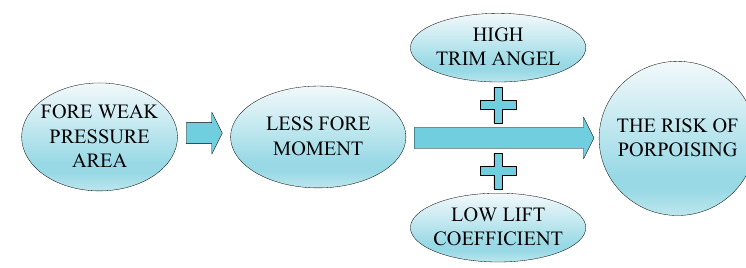
Figure 19. Why porpoising occurs.